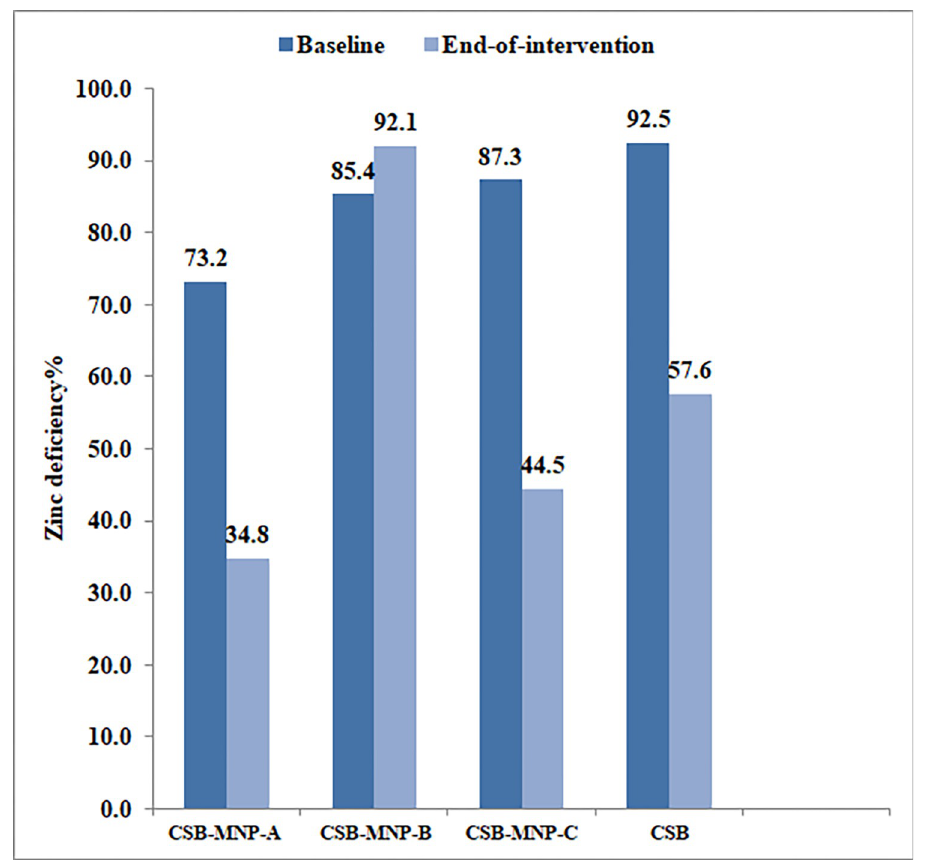
Fig 2. Zinc deficiency levels at baseline and end-of-intervention by study group.